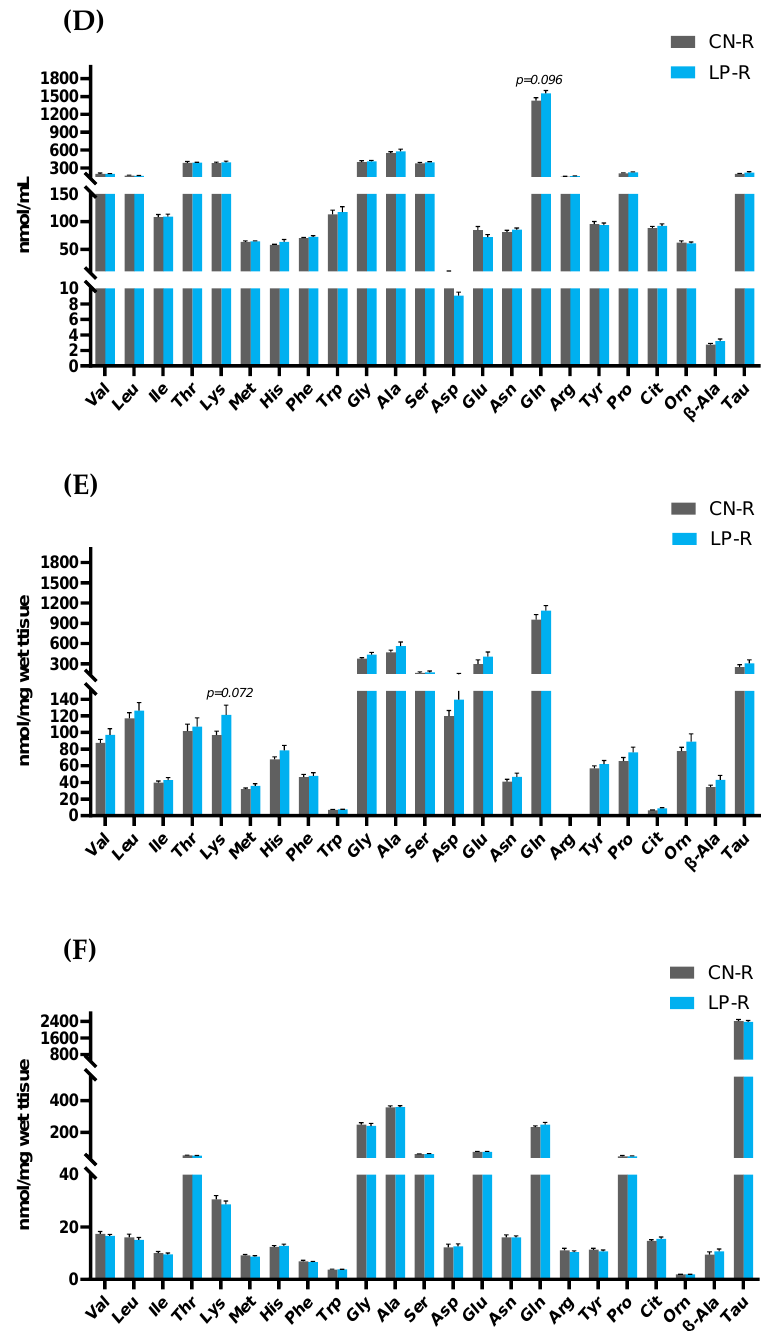
Figure 2. Effects of low protein diet and rebound feeding of control diet on amino acid profiles of LP and CN rats ( A – C ) during regular feeding in ( A ) plasma, ( B ) liver, and ( C ) gastrocnemius muscle; ( D – F ) during rebound feeding in ( D ) plasma, ( E ) liver, and ( F ) gastrocnemius muscle. Data are shown as means ± SEM; n = 6 or 7. CN, control diet (15% casein); LP, low-protein diet (8% casein); CN-R, rebound feeding group fed with control diet after 4 weeks of normal feeding; LP-R, re-bound feeding group fed with control diet after 4 weeks of low-protein diet feeding; * p < 0.05, ** p < 0.01, and *** p < 0.001 vs. CN. Val, valine; Leu, leucine; Ile, isoleucine; Thr, threonine; Lys, lysine; Met, methionine; His, histidine; Phe, phenylalanine; Trp, tryptophan; Gly, glycine; Ala, alanine; Ser, serine; Asp, aspartic acid; Glu, glutamic acid; Asn, asparagine; Gln, glutamine; Arg, arginine; Tyr, tyrosine; Pro, proline; Cit, citrulline; Orn, ornithine; β -Ala, β -alanine; Tau,